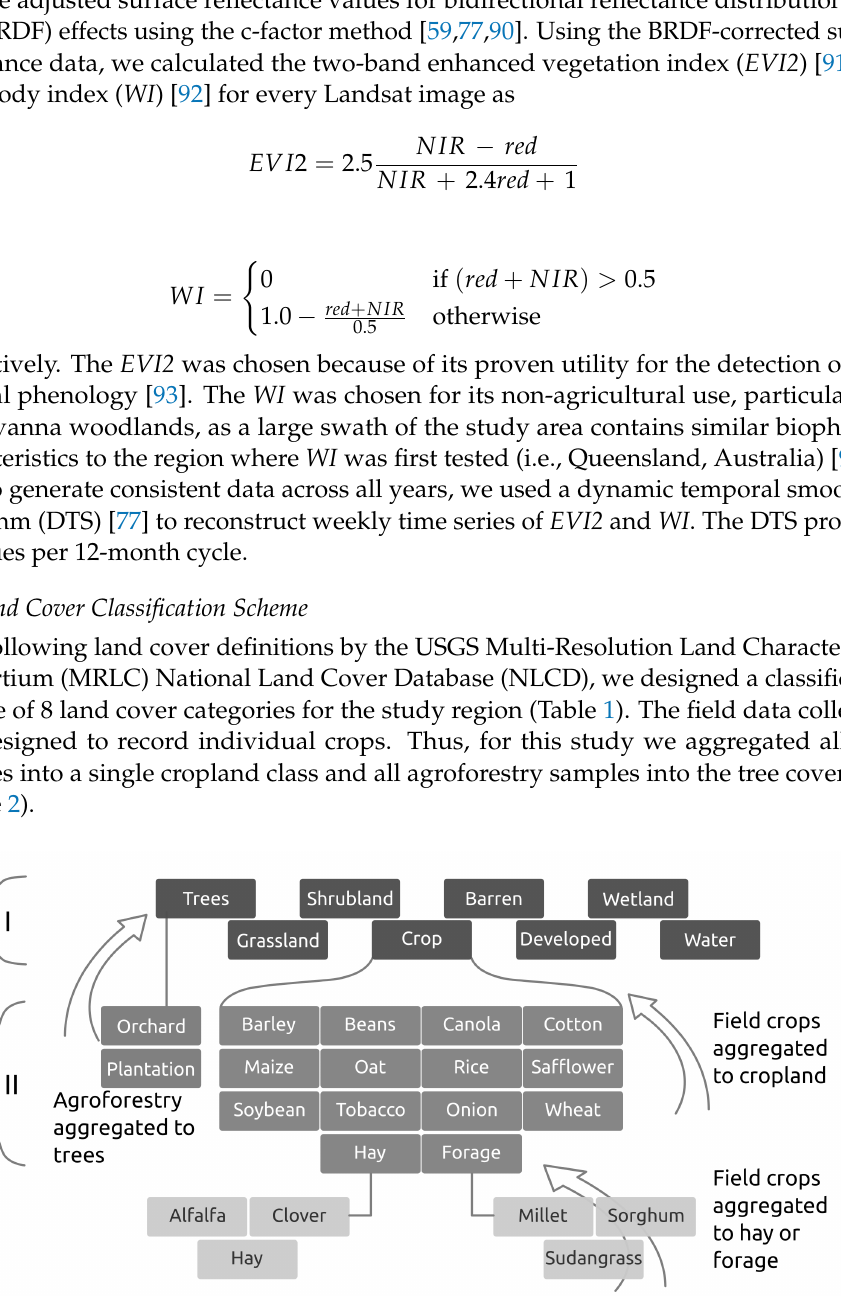
Figure 2. The classification hierarchy. Level I consists of dominant land cover categories estimated in this study. Level II illustrates the cropland category as collected in the